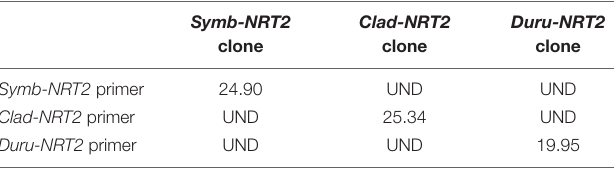
TABLE 2 | Specificity of the three sets of quantitative real-time PCR (qPCR) primers designed for nitrate transporter 2 ( NRT2 ) of Symbiodinium ( Symb-NRT2 ), Cladocopium ( Clad-NRT2 ) and Durusdinium ( Duru-NRT2 ) derived from the outer mantle of Tridacna squamosa , as demonstrated by qPCR using three different plasmid clones with each clone containing specifically the insert of the amplicon region of the Symb-NRT2, Clad-NRT2, or Duru-NRT2 primers.